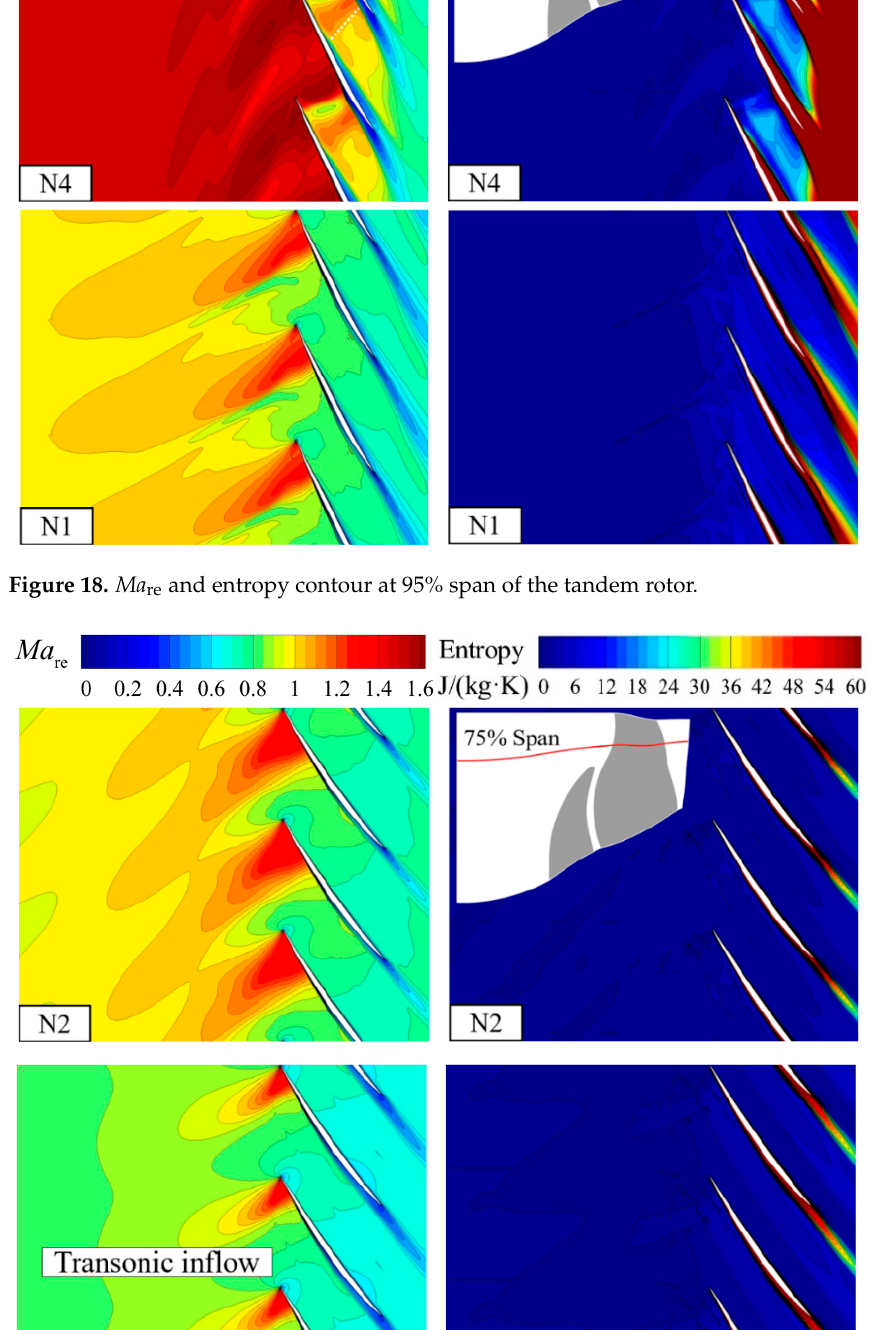
Figure 18. Ma re and entropy contour at 95% span of the tandem rotor.